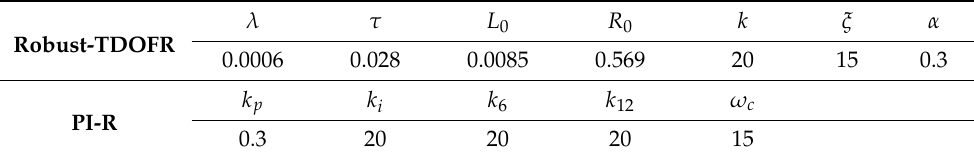
Table 2. Parameters of the